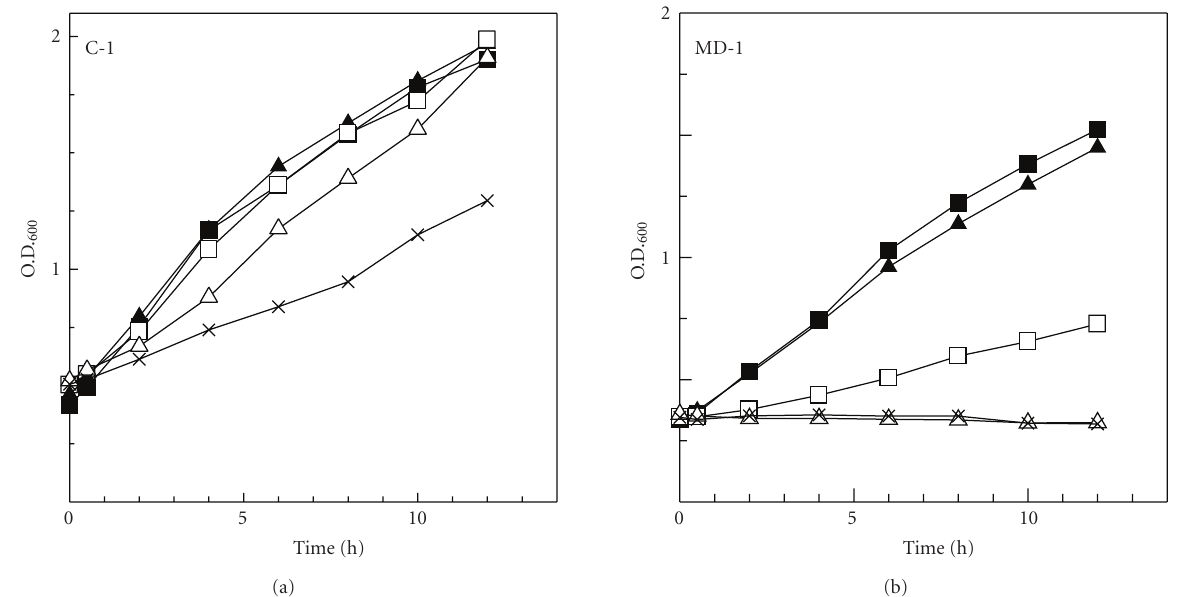
Figure 2: E ff ect of pH on growth of MC-degrading bacteria. (a) Sphingopyxis sp. strain C-1, (b) Novosphingobium sp. strain MD-1. Values presented are the means of 3 replicates. (cid:2) : pH 7.00, (cid:3) : pH 8.00, (cid:4) : pH 9.00, (cid:5) : pH, 10.0, × :